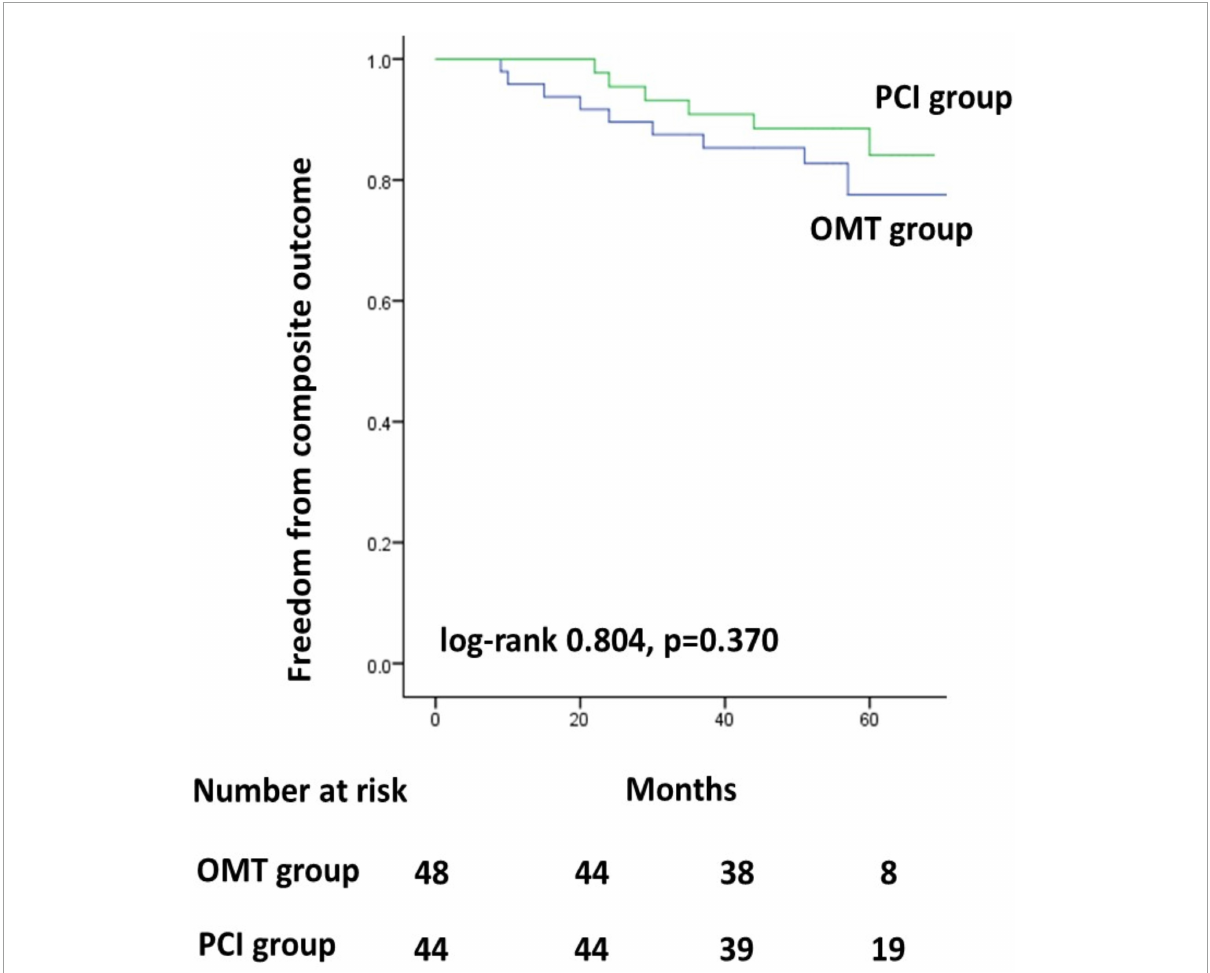
FIGURE1 Kaplan–Meier survival curves for the MACE. PCI, percutaneous coronary intervention; OMT, optimal medical